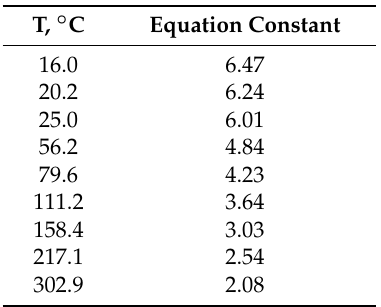
Table 1. Equilibrium constant of reaction (4), from